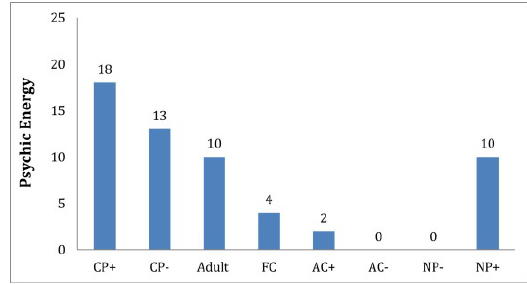
Chart 9: Egogram Teacher 5 with Student 1 Chart 9 illustrates the egogram of Teacher 5 with Student 5-1. The proportion of NP+ is higher than the proportion of Adult and FC in this chart. The proportion of FC is that same as Charts 1, 6, 7, and 9.